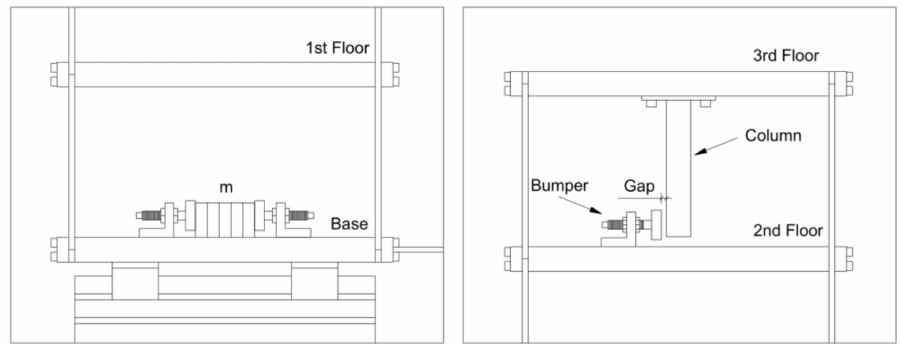
Figure 16. Descriptions of the three-story building structure.